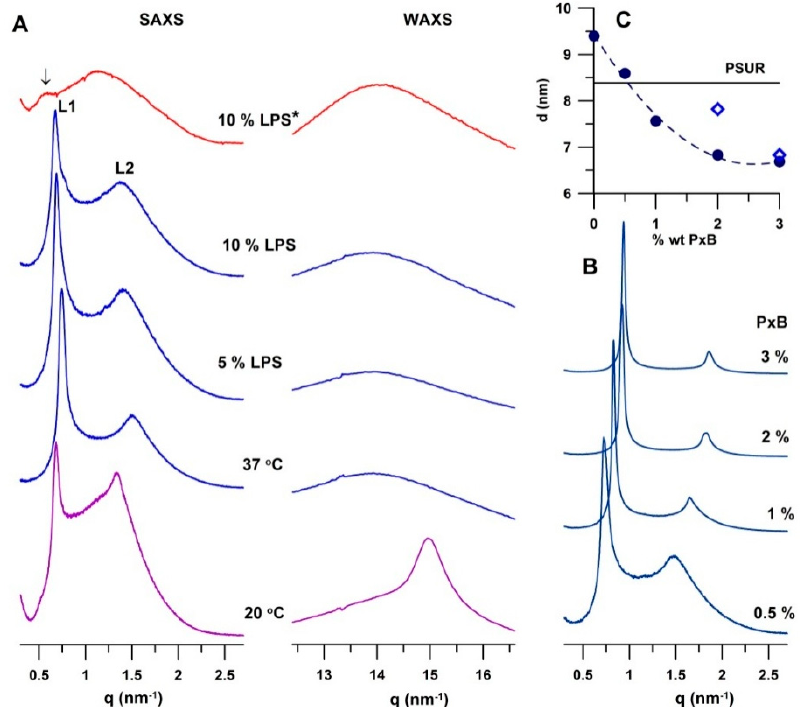
Figure 4. ( A ) Small- and wide-angle X-ray scattering (SAXS/WAXS) patterns of the modified pulmonary surfactant (PSUR) at 20 and 37 °C, and PSUR incubated with either 5% or 10% LPS for 30 min and 2 h (pattern at the top, marked with asterisk). An arrow indicates the first order peak of a lamellar phase with d ~ 12.6 nm; ( B ) SAXS patterns of PSUR/10% LPS/PxB, for which samples were incubated for 30 min; ( C ) the dependence of the repeat distance of PSUR/LPS/PxB system as a function of PxB concentration. Empty symbols are related to d of PSUR/10% LPS/PxB after longer incubation (2 h). Solid line represents the repeat distance of PSUR without any additives.